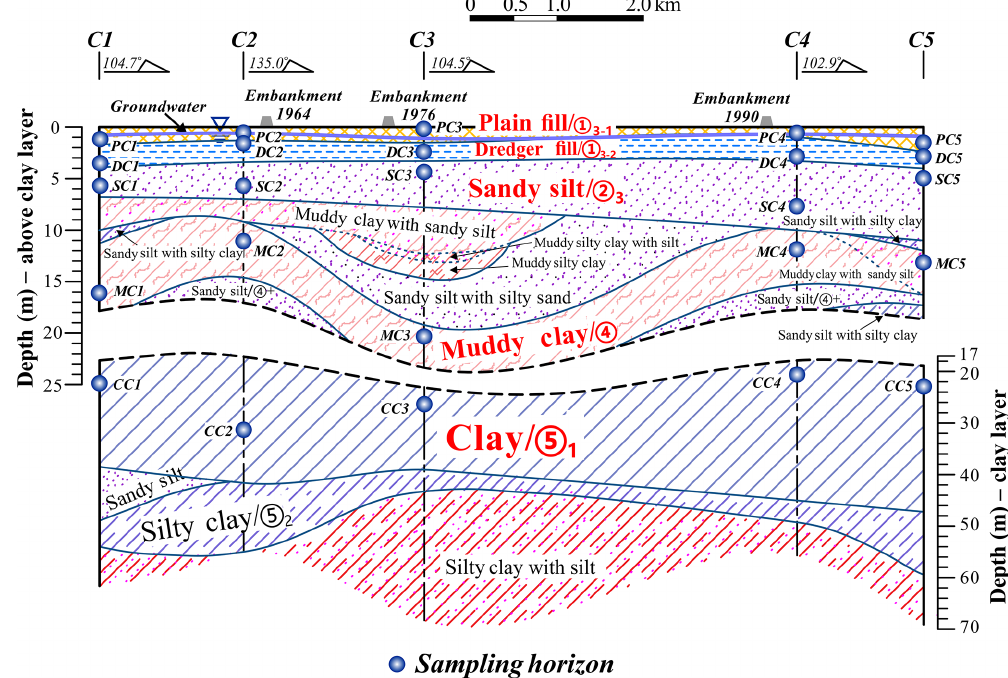
Figure 3. Engineering geologic layers of profile line C1–C5.